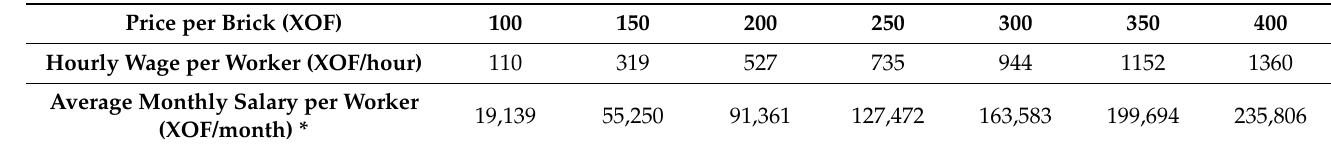
Table 4. Hourly and monthly wages per worker as a function of manufactured price per brick using propane as heat energy